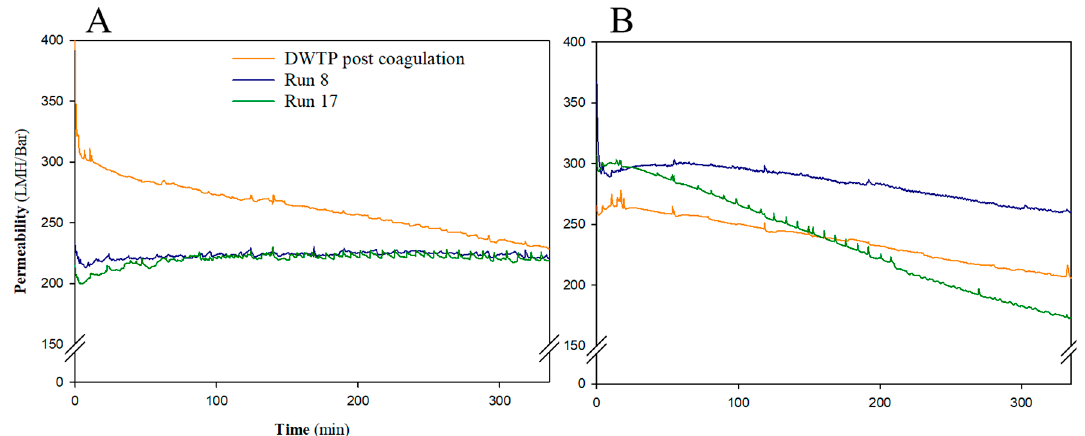
Figure 7. Evolution of permeability during UF experiments before ( A ) and after ( B ) flood.